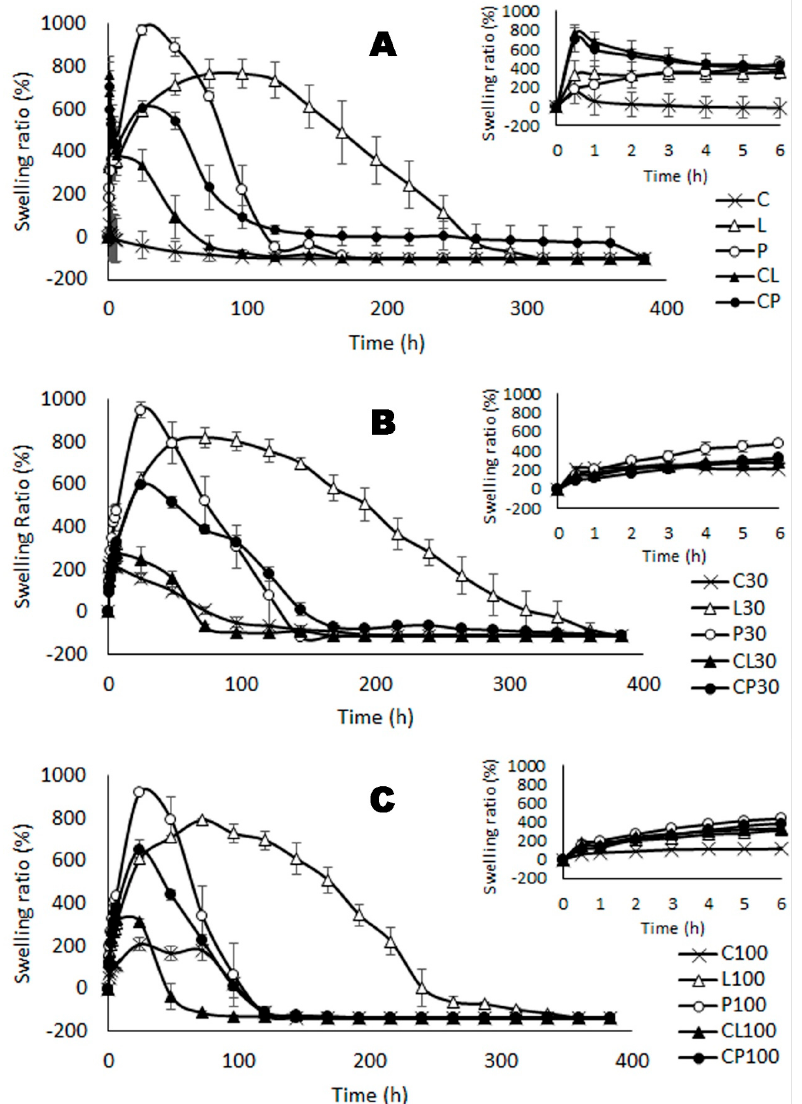
Figure 3. Swelling ratio values vs. time in the tablets containing no drug ( A ), 30 mg ( B ) or 100 mg ( C ) of TFV. The first 6 h are shown in detail in the small graphics in the top right corner.